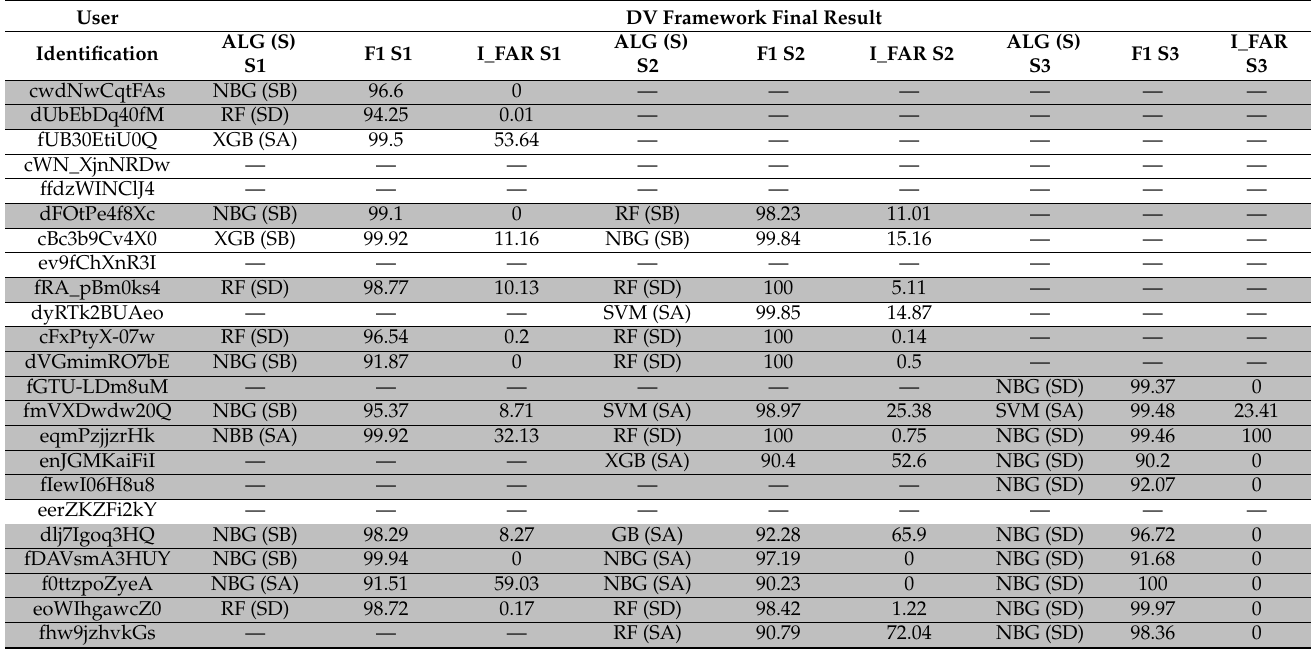
Table 13. Final results for the DV framework scenario.